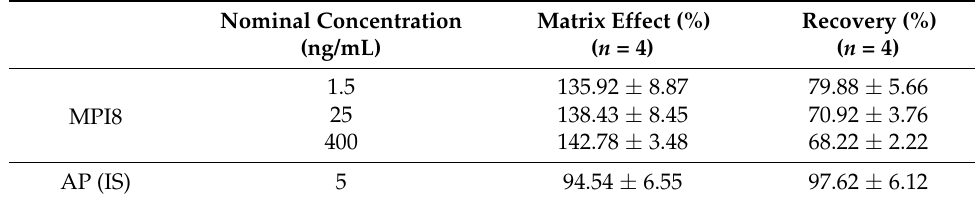
Table 3. Recovery and matrix effect of MPI8 and AP.